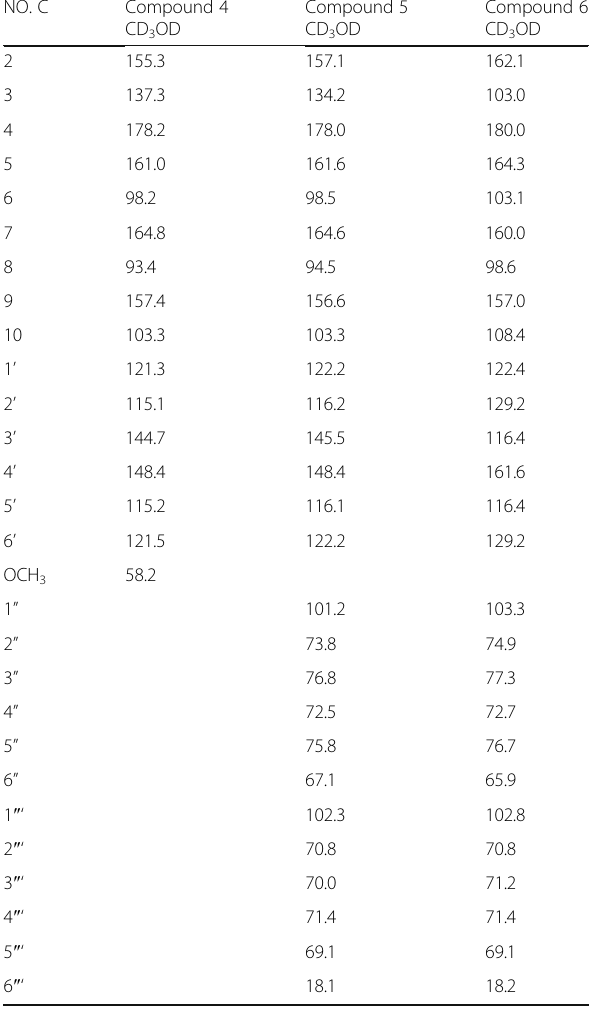
Table 5 13 C NMR (100 MHz) data of compounds 4 –